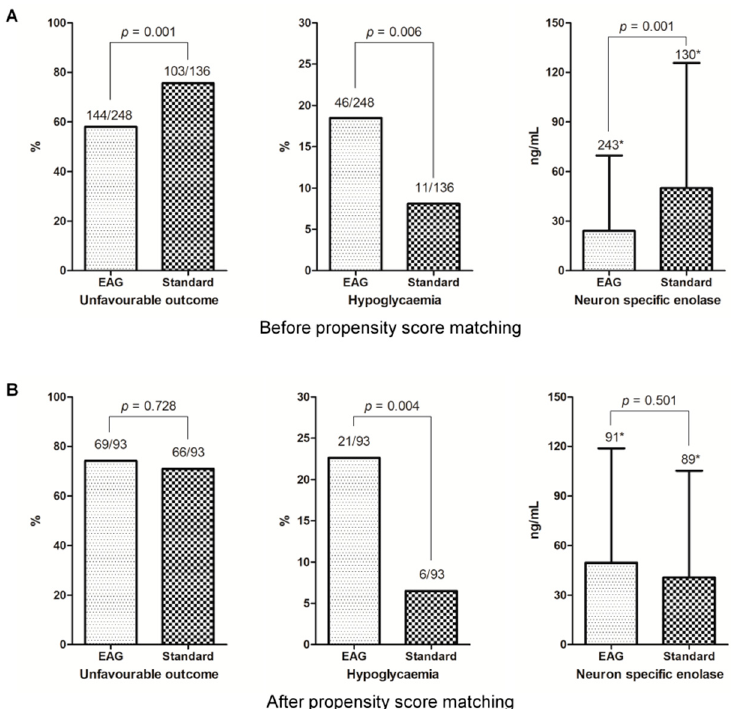
0.011 EAG, estimated average glucose; ASD, absolute standardized difference; IQR interquartile range; NA, not applicable; OHCA, out-of-hospital cardiac arrest; CPR, cardiopulmonary resuscitation; ROSC, restoration of spontaneous circulation; SOFA, sequential organ failure assessment; TH therapeutic hypothermia; HbA1c, glycated hemoglobin; PaO 2 , partial pressure of oxygen; PaCO 2 , partial pressure of carbon dioxide. * Number of patients included in the analysis. 3.2. Outcomes Unfavorable neurologic outcome at 6 months after cardiac arrest occurred in 247 (64.3%) patients, and hypoglycemia developed in 57 (14.8%), among the entire cohort. Figure 3 shows the associations between outcomes and the EAG or standard group. The EAG group was associated with favorable neurologic outcome ( p < 0.001), higher incidence of hypoglycemia ( p = 0.006), and lower serum NSE levels at 48 h after cardiac arrest ( p = 0.001), in the entire cohort (Figure 3A).